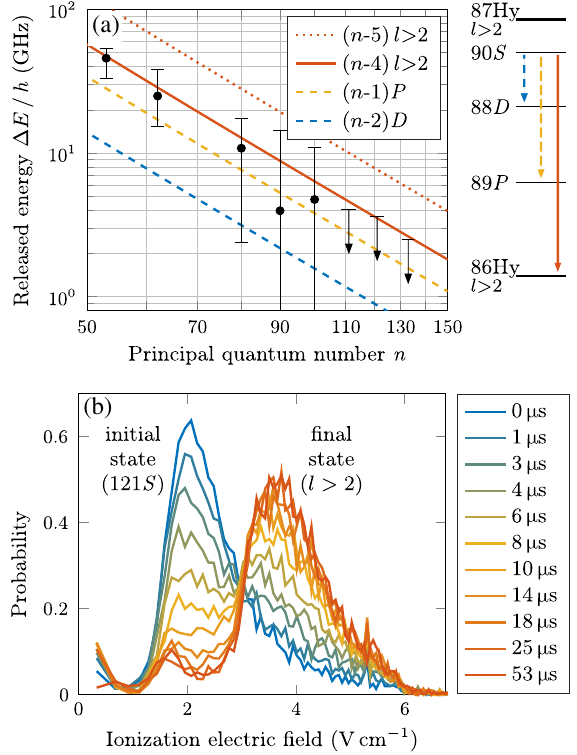
FIG. 3. (a) Released energy during the l -changing collision. The black dots indicate the most likely released energy during a collision, whereas the bars indicate the full width at half maximum of the fitted probability distribution of the released energy. The energies observed correspond to a state change to the next-lower hydrogenic manifold ( n − 4 ). For n ≥ 110 , the most likely kinetic energy gained is not shown anymore because the released energy is too low to extract a well-defined maximum out of the energy distribution, which is depicted by the arrow. The colors of the released energies are according to the level scheme shown on the right, in which Hy denotes the hydrogenic manifold. (b) State selective ionization analysis of the detected ions for a 121 S state. With an immediate (blue curve) linear ionization field ramp going to 6 V cm − 1 within 3 μ s applied after the 500-ns excitation pulse, almost all atoms arrive between 1 and 3 V cm − 1 , corresponding to the initially excited 121 S state. With a delayed ionization, the Rydberg atom undergoes an inelastic collision (red: delay of 53 μ s), and the required ionization voltage changes by a factor of 2 to 4, corresponding to a high l state